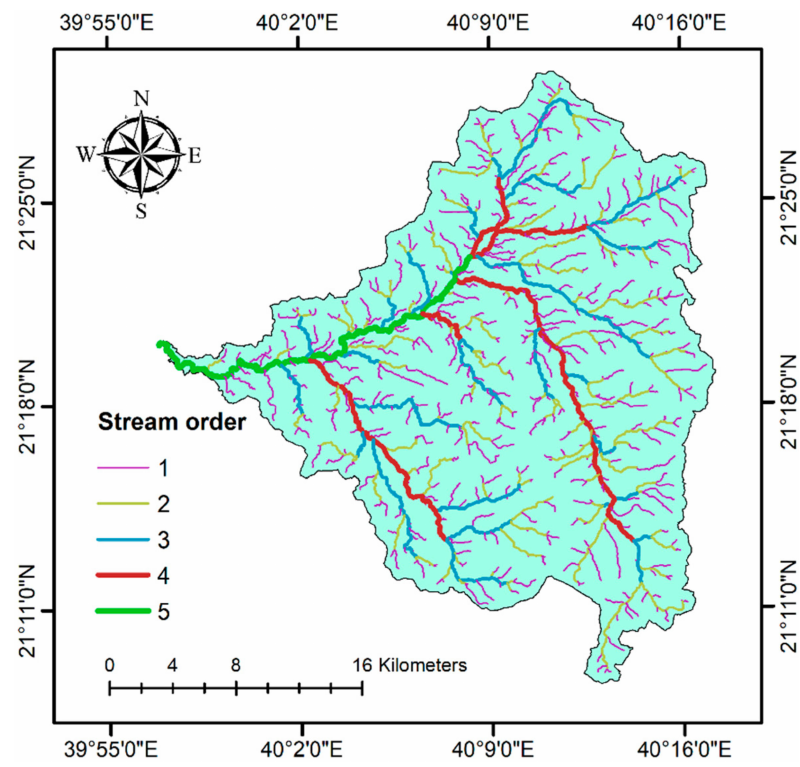
Figure 4. Delineation of Wadi Nu’man watershed